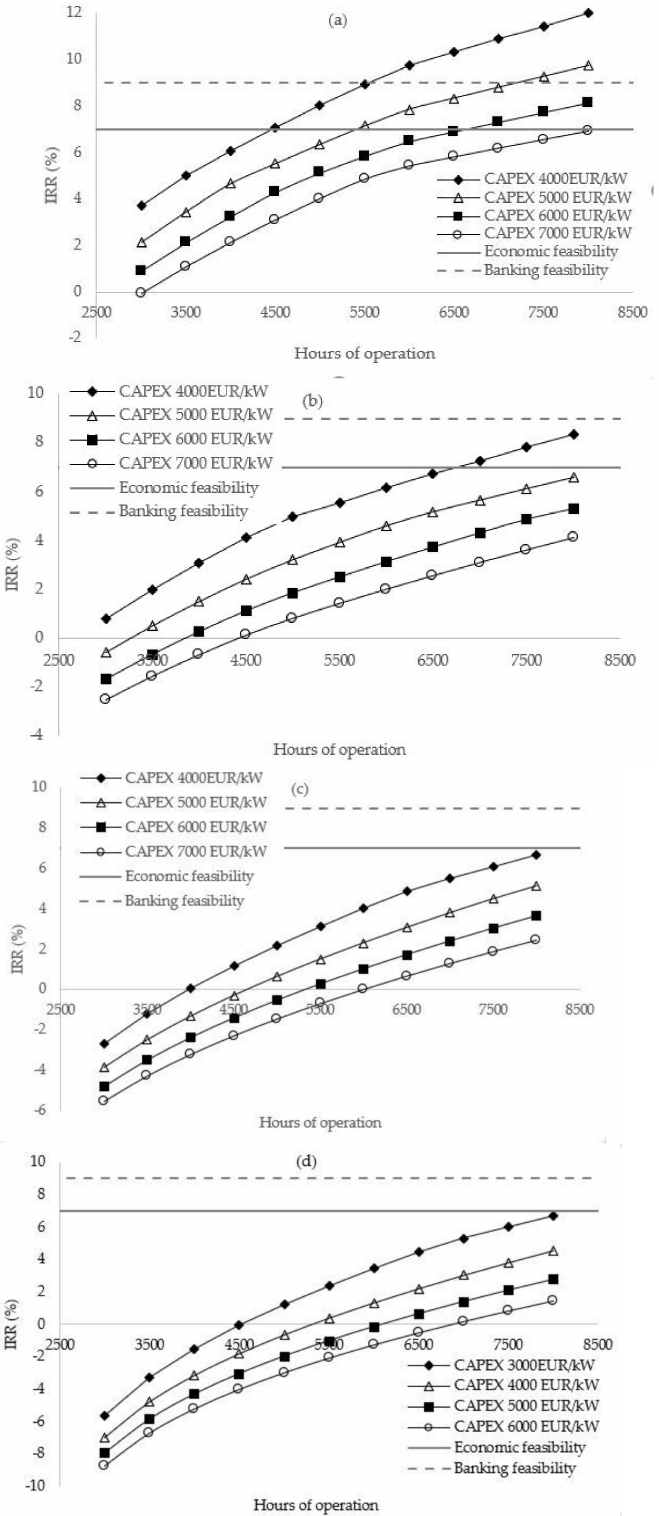
Figure 4. Internal rate of return vs. hours of operation for different capital expenditures for systems of 100 kW ( a ), 250 kW ( b ), 500 kW ( c ), and 1000 kW ( d